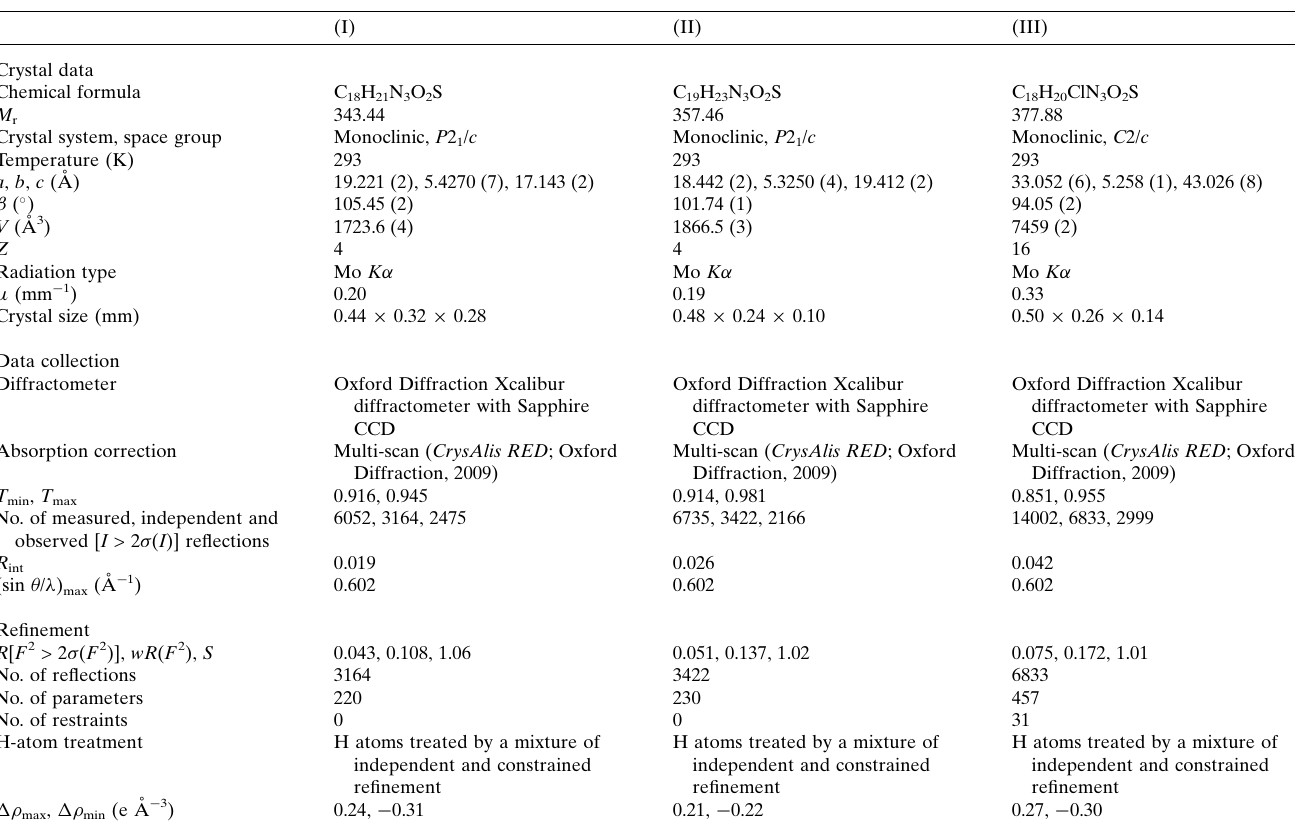
Table 4 Experimental details.